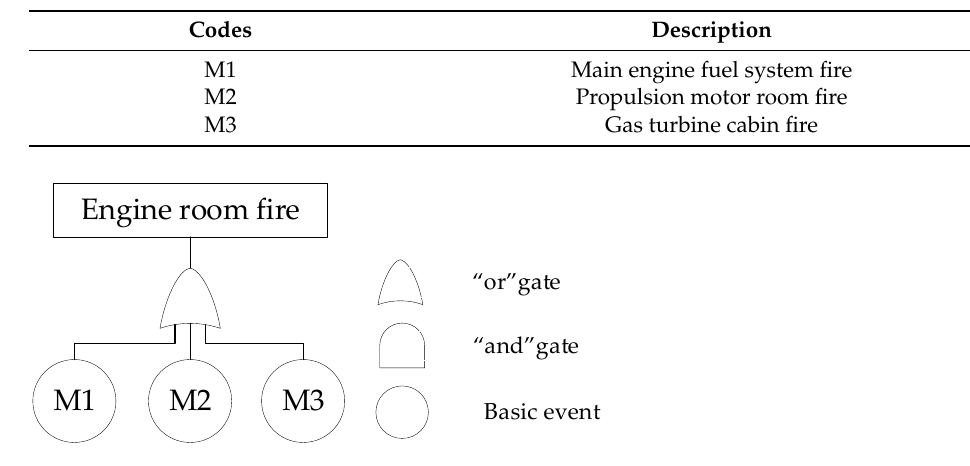
Figure 3. Fault tree of an engine room fire.